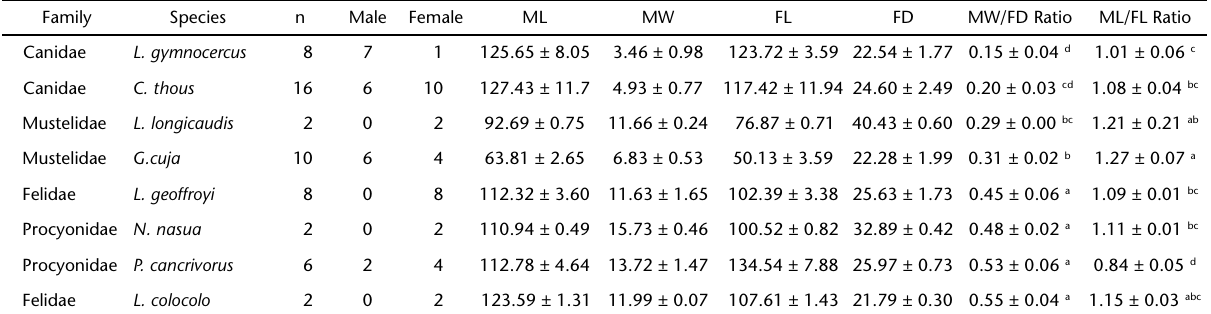
Table I. Means and standard deviations (mm) of the measurements and MW/FD and ML/FL ratios obtained from the forelimbs (n = 54) of carnivorans specimens that presented the brachioradialis muscle. Family